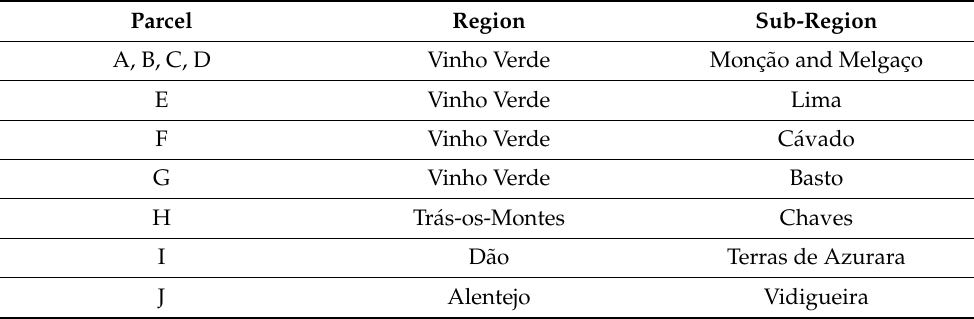
Table 1. Origin of the samples. Parcel designation and the identification of its corresponding